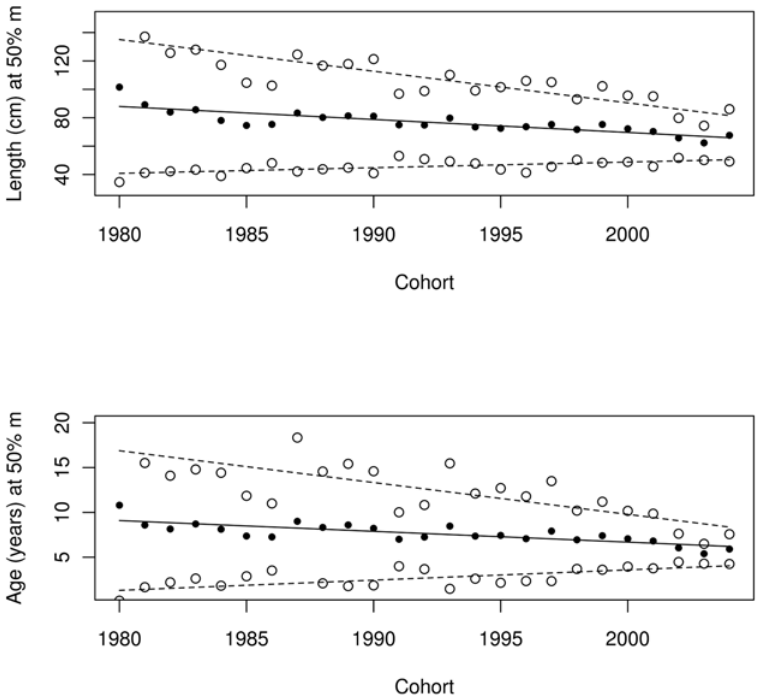
Figure 4. Probabilistic maturation reaction norms: length and age at 50% probability of maturing on cohort. Solid dots and solid lines represent length or age at 50% probability of maturing. Upper and lower open dots and dashed lines represent length or age at 95 and 5% probability of maturing respectively. Lines are linear regression of length or age on cohort. Based on data on mean length, age and maturity ratio from table 3.1.4 in Anonymous [27] (and see